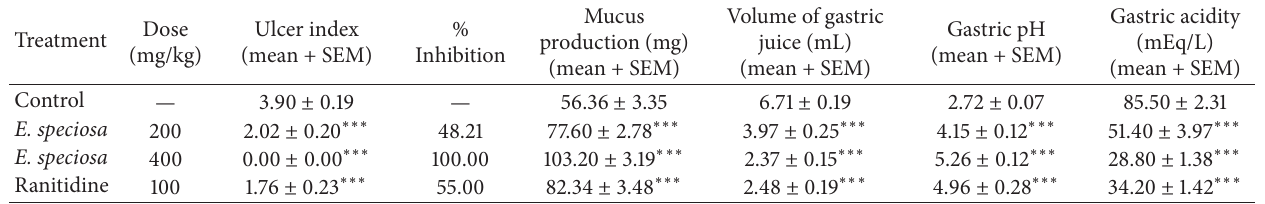
Table 6: Effects of duodenally administered aqueous extract of E. speciosa on gastric ulceration and secretion induced by carbachol in rats. Treatment